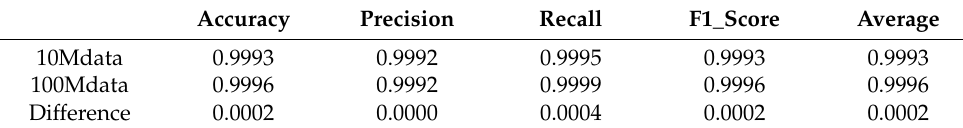
Figure 24. Performance comparison of increasing DDoS dataset.